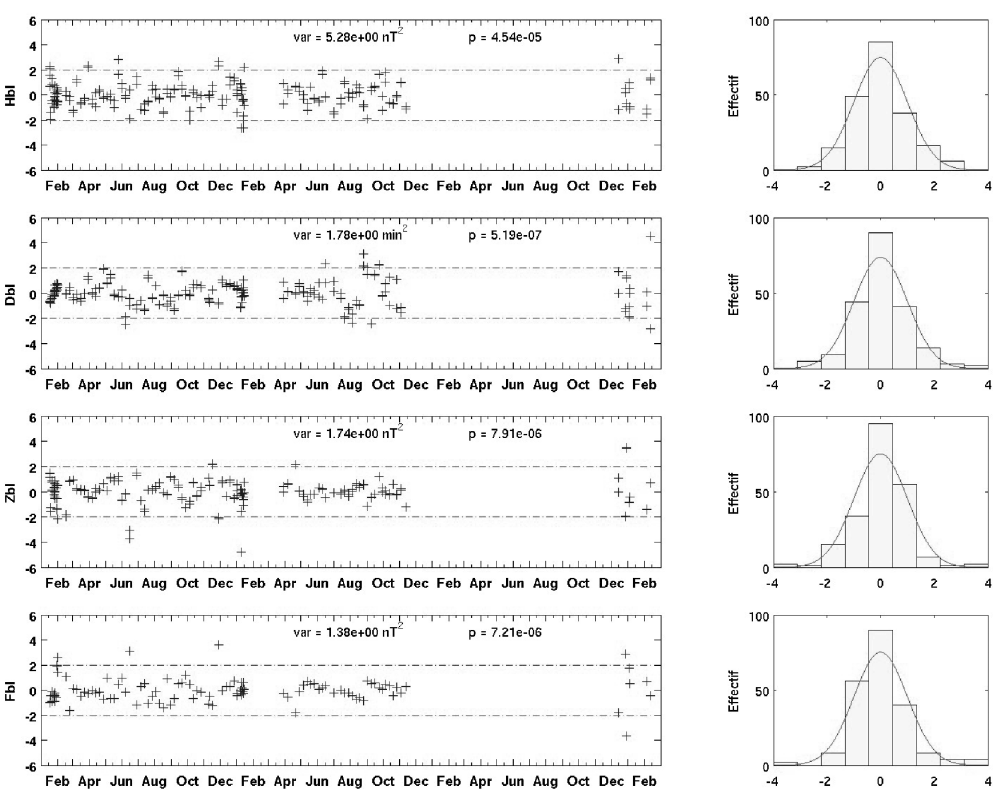
Fig. 3. Left part: studentized (dimensionless) residuals versus time for each component of the base lines shown on fig. 2 var stands for the variance of the statistical model, p for the smoothing factor. Right part: distribution of studentized residuals compared to a Normal Gaussian